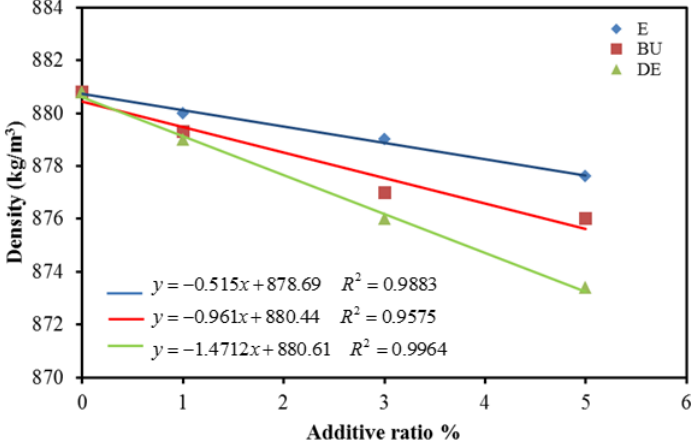
Figure 7. Variation in palm oil methyl ester density with increasing blending ratio for different additives.